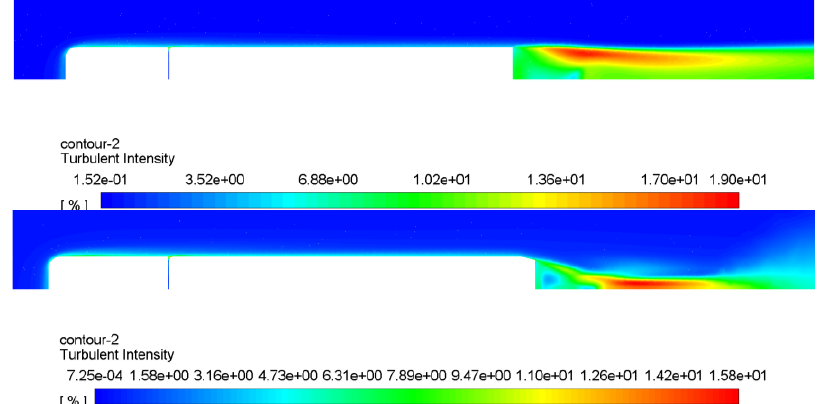
Fig. 17. Plan view comparison of the turbulent intensity of the flow between Concept Two – Revision A (top), and Concept Two – Revision B